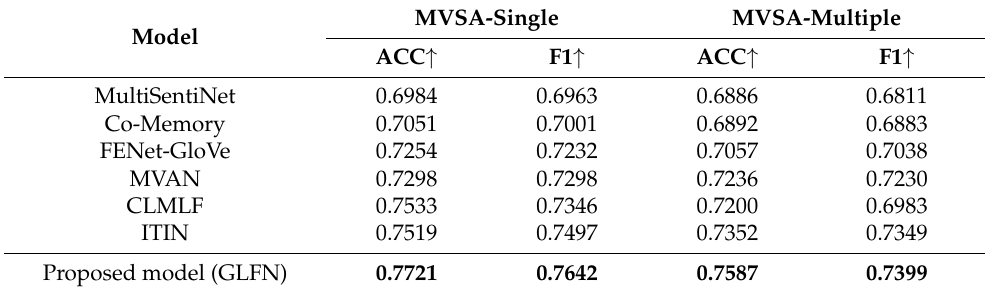
Table 1. Comparative results of GLFN and baselines on MVSA datasets, ACC represents accuracy and F1 denotes F1 score ( ↑ denotes the value is larger, the performance of model is